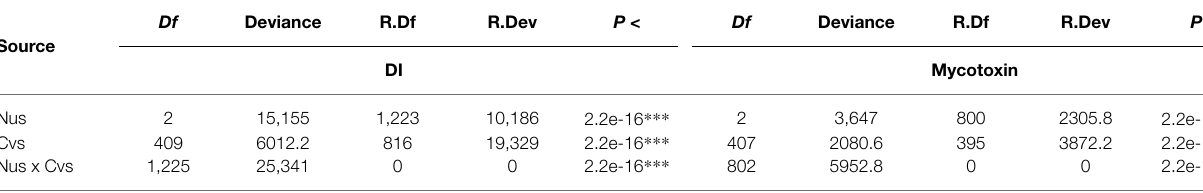
R represent resid. ***Indicates significant at p < 0.001.